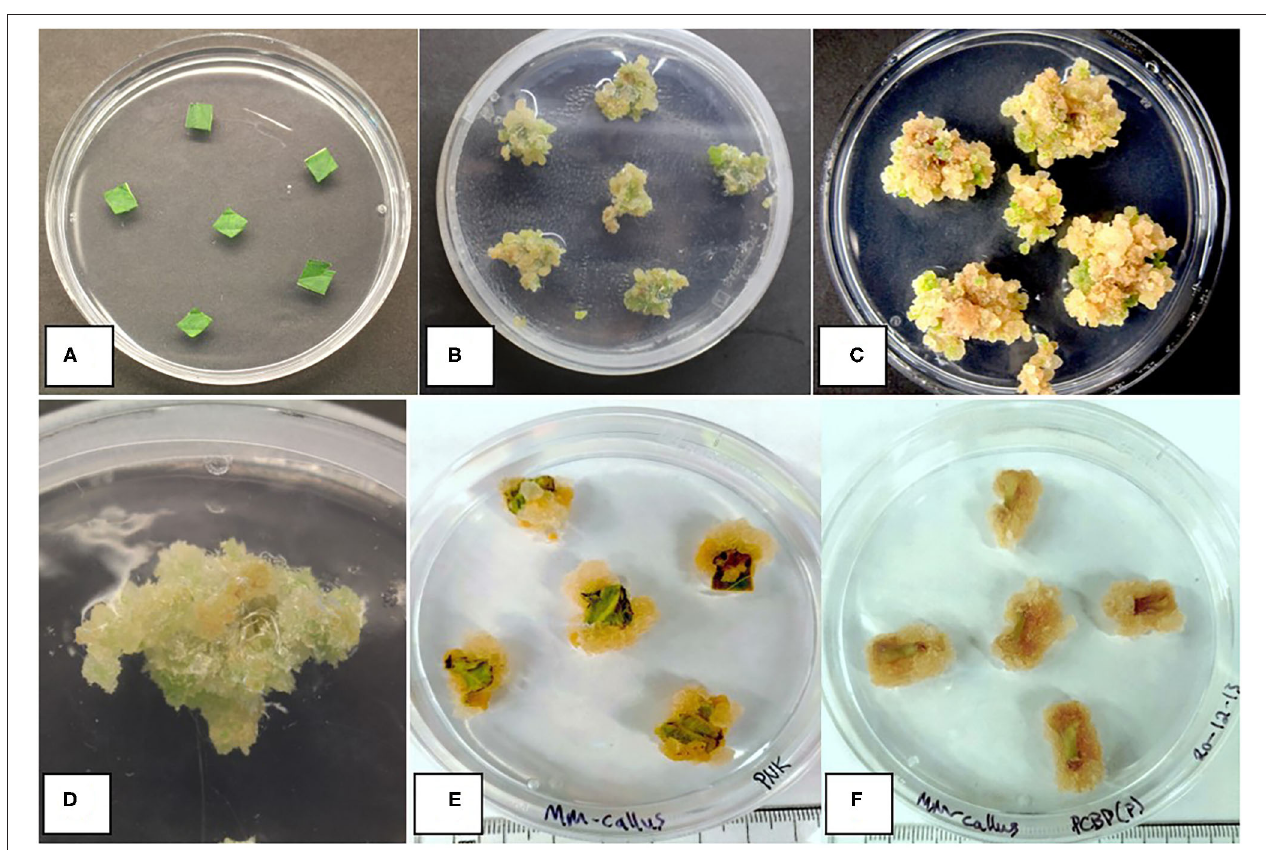
FIGURE 10 | Callus development on leaf and petiole explants of different cannabis genotypes on MM-AC. (A) Leaf explants at the start of the experiment from a donor plant. (B) Callus from leaf explants of genotype SPQ after 8 weeks of growth. Variation in callus growth between explants can be seen. (C) Callus growth of genotype GSC from leaf explants after 8 weeks of growth. (D) Callus from leaf explants of genotype SPQ after 8 weeks of growth. (E) Callus from leaf explants of cannabis genotype Pink Kush after 8 weeks in the dark. (F) Callus from petiole explants of cannabis genotype Pure CBD after 8 weeks in the dark. No evidence of shoot development was observed in any of the callus